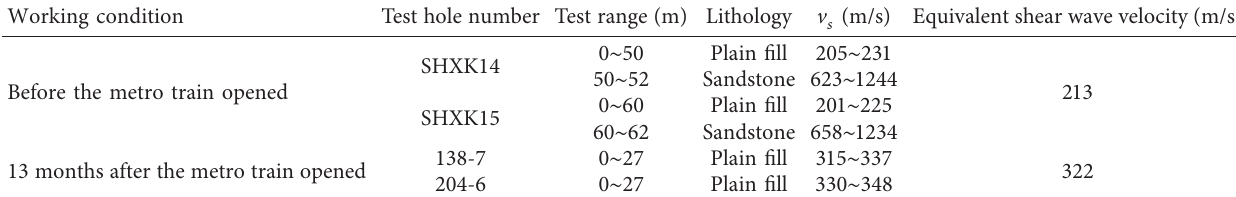
Table 5: Shear wave velocity test